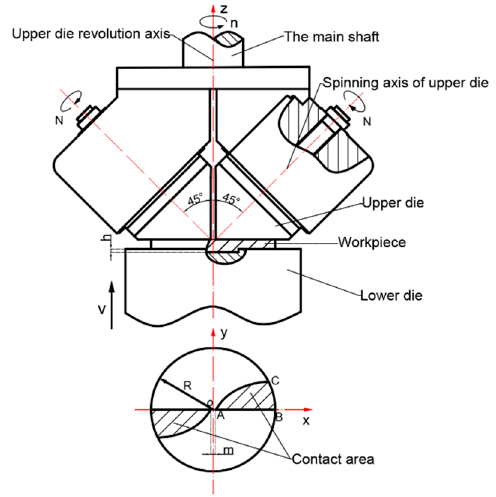
Figure 1. Working principle of integral forming of large diameter thin-walled metal disk double-roller rotary forging.